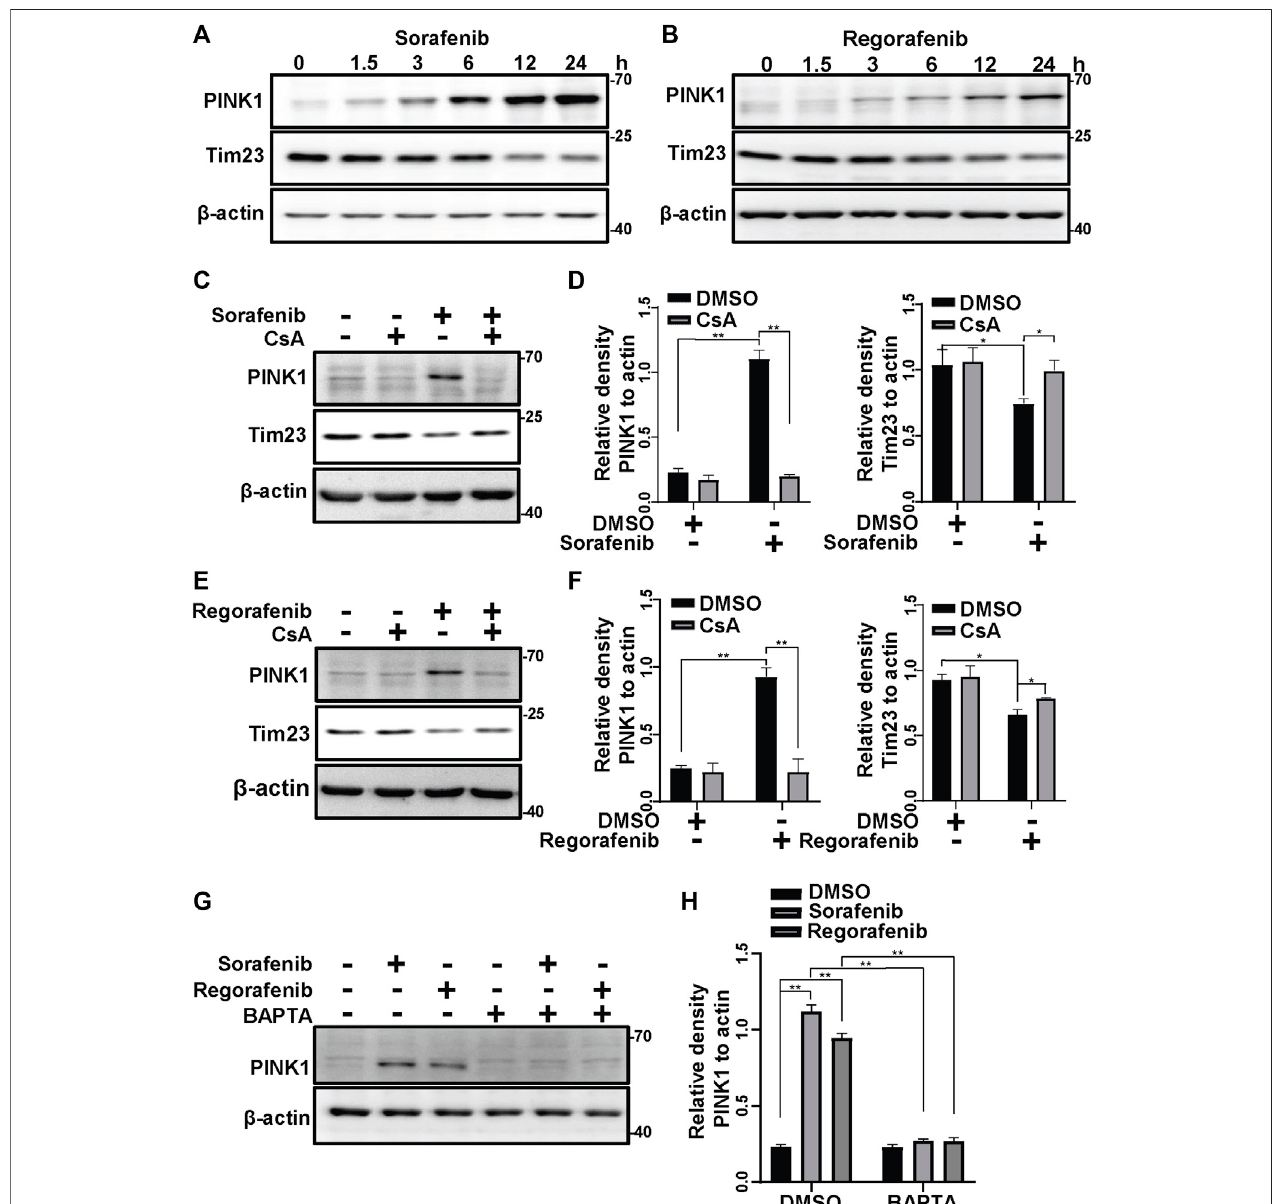
FIGURE 2 | Sorafenib and regorafenib activate PINK1 via mPTP opening. (A, B) PINK1 and Tim23 in HepG2 cells that were treated with sorafenib (20 μ M) or regorafenib (30 μ M) at differenttimepoints(1.5, 3,6, 12,24 h)were labeled with theindicated antibodies. (C) HepG2 cellsthat werepretreated withCsA(20 μ M) for 1 h and then treated with sorafenib (20 μ M) for 4 h were subjected to western blotting with the indicated antibodies. (D) The relative densities of PINK1 and Tim23 were quanti fi ed, andtheirprotein levelswerenormalized totheloadingcontrol β -actin. Values arethemean±SEMfrom threeindependentexperiments(* p < 0.05,** p < 0.01, two-way ANOVAand Tukey ’ s multiple comparisons test). (E) The experiments assameas (C) were performed but the cells were treated with regorafenib (30 μ M) for4 h. (F) Thequanti fi cationofthedatafrom (E) wereanalyzed as (D) . Valuesarethemean±SEMfrom threeindependentexperiments(* p < 0.05, ** p < 0.01, two-way ANOVA and Tukey ’ s multiple comparisons test). (G) HepG2 cells that were pretreated with BAPTA (10 μ M) for 1 h and treated with sorafenib (20 μ M) or regorafenib (30 μ M)for4 hweresubjectedtowesternblottingwiththeindicatedantibodies. (H) TherelativedensityofPINK1wasquanti fi ed,andtheproteinlevelwasnormalizedto that of the loading controls ( β -actin). Values are the mean ± SEM from three independent experiments (** p < 0.01, two-way ANOVA and Tukey ’ s multiple comparisons test).